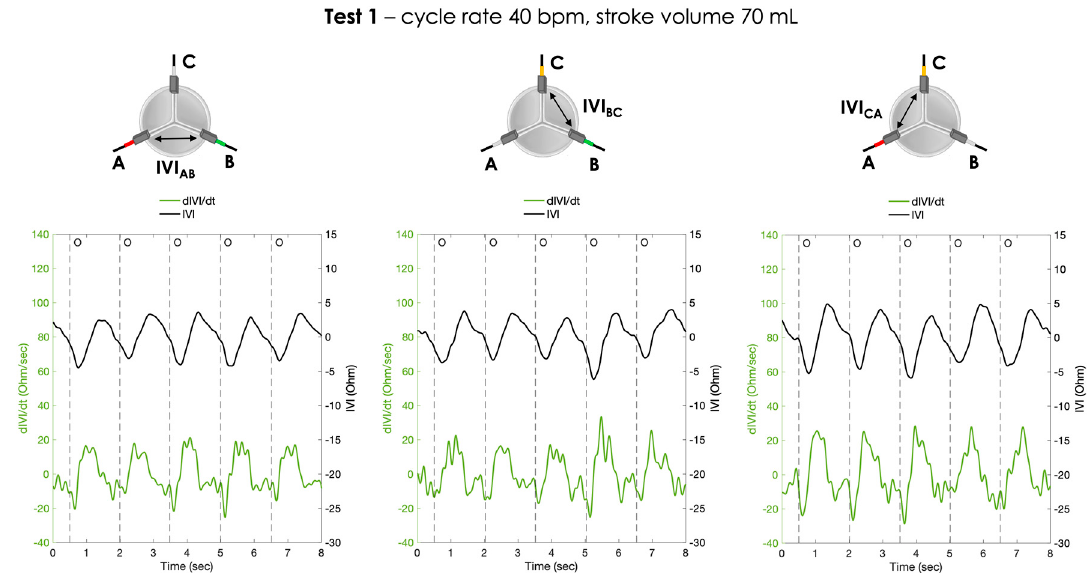
Figure 9. The IVI signal (black line) and the corresponding first derivative dIVI/dt (green line) obtained for the three pairs of electrodes during Test 1 (cycle rate 40 bpm, stroke volume 70 mL). AB ( left ), BC ( center ) and CA ( right ). O = start of valve opening identified with the low peak of the aortic pressure.